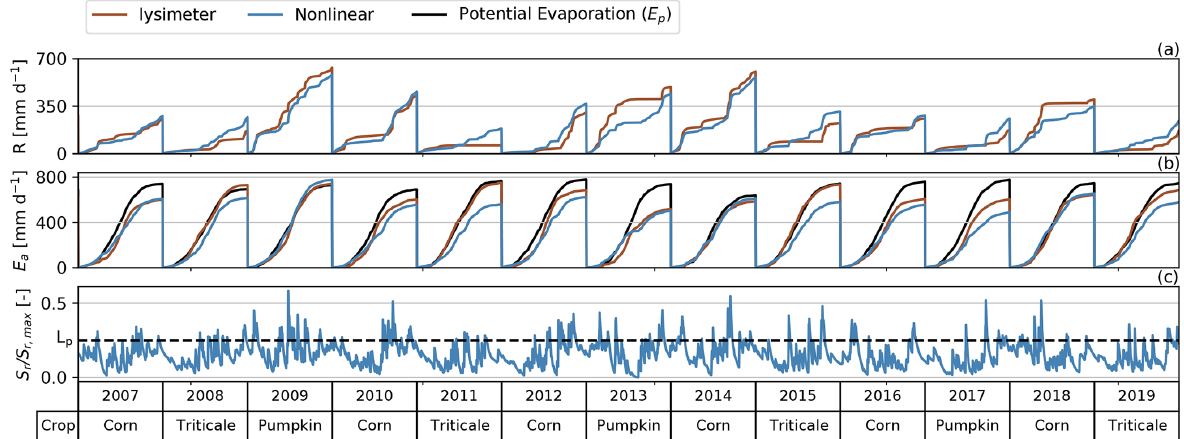
Figure 10. Yearly cumulative sums of recharge (a) , the actual and potential evaporation (b) , and the saturation of the root zone (c) . The dashed line in plot (c) denotes the value of l p , where the evaporation from the root zone will equal the potential